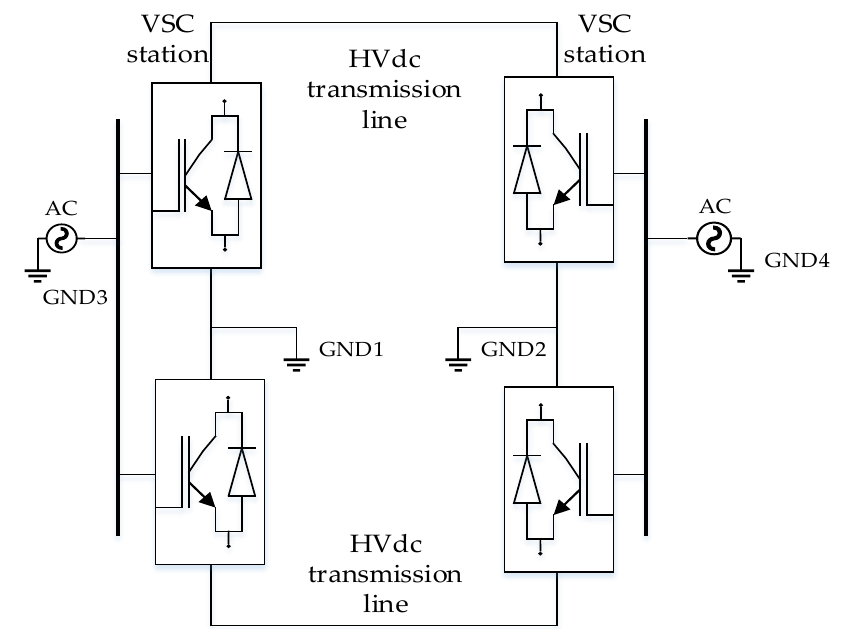
Figure 20. Bipolar high-voltage direct current (HVdc) transmission line model.